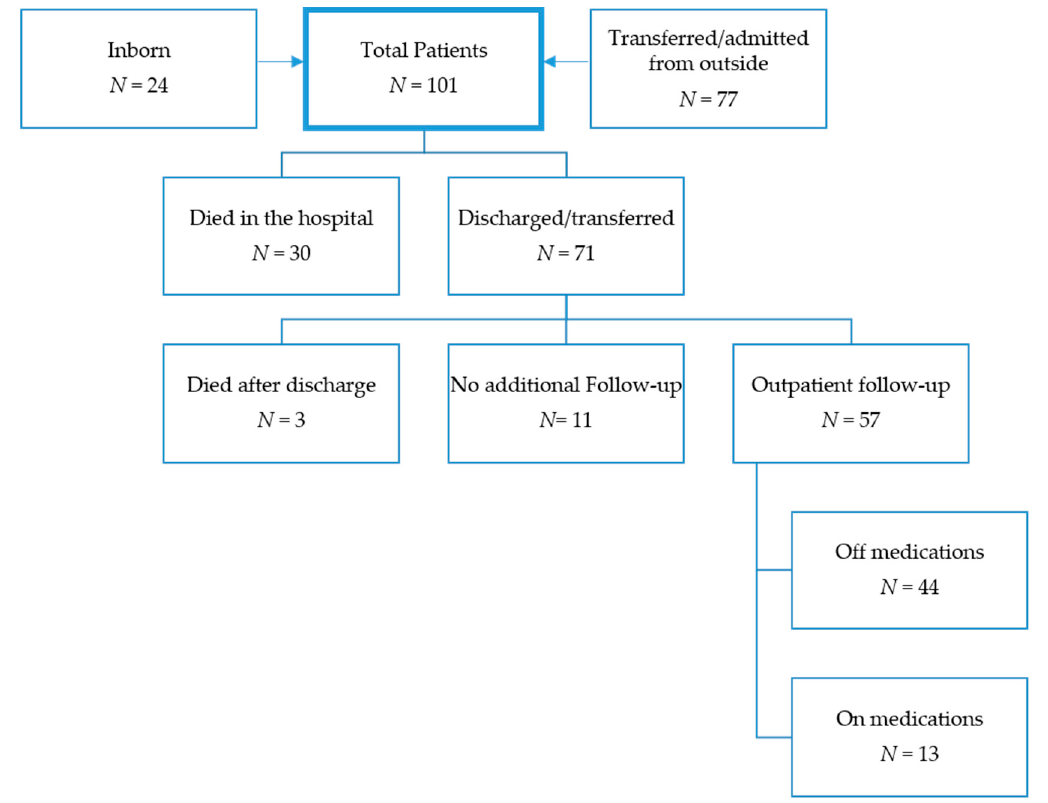
Figure 1. Patient flowchart.